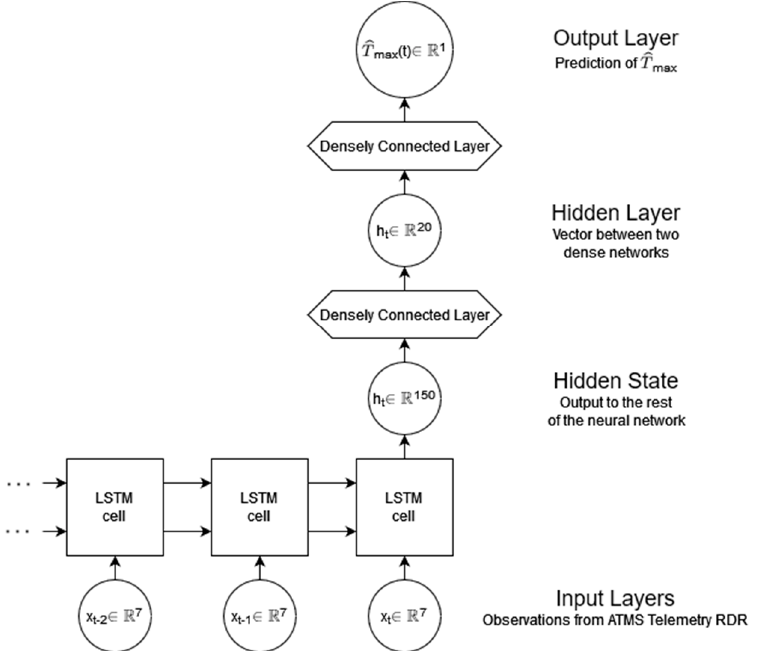
Figure 2. Simplified schematic showing how a series of sequentially arranged LSTM cells are connected. A prediction ( ˆ T max ) is created by passing the output of a single LSTM cell through two deeply connected layers. The LSTM output is a function of the most recent input vector and the two output vectors produced by the previous LSTM cell in the temporal sequence.